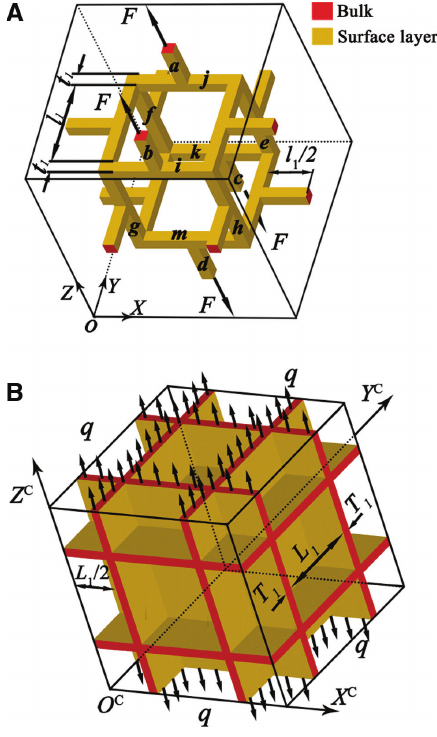
Figure 5 Cubic unit cell model for nanoporous materials with a surface effect: (A) open cell model; (B) closed cell model